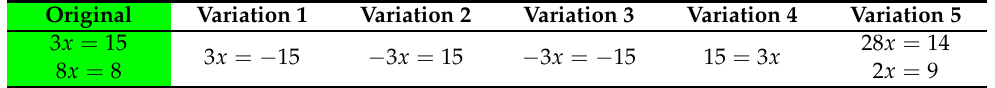
Table 5. Examples of type 4 equations and variations.